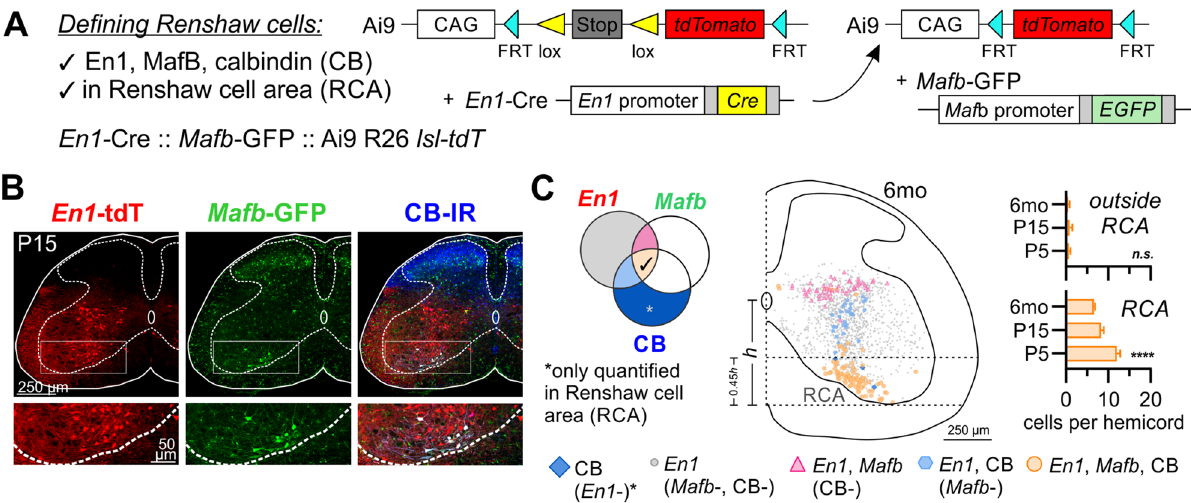
Figure 1. Genetic strategy to identify and define Renshaw cells. (A) Triple transgenic En1- Cre :: Mafb- GFP :: Ai9 R26 lsl-tdT animals label Mafb- expressing cells with GFP and the V1 lineage with tdTomato (tdT). ( B) 2D projection of a triple fluorescence confocal image stack (50 µm thick) showing En1 -tdT (V1 interneurons, red), Mafb- GFP (green), and calbindin immunoreactivity (CB-IR, blue) at P15. ( C) Venn diagram illustrates co-localization possibilities between En1 -tdT, Mafb- GFP, and CB-IR; colors match cell plots obtained from a 6-month old animal (12 superimposed 50 µm thick sections). V1-MafB cells appear as distinct dorsal and ventral groups; the ventral group is CB-IR and corresponds to Renshaw cells. The Renshaw cell area (RCA) was anatomically defined as the bottom 45% of the deep ventral horn. This region includes the vast majority of triple-labeled cells ( ● orange circles); less than one triple-labeled cell per hemicord was observed outside this region across all time points. Graphs show quantification of triple-labeled cells at P5, P15, and 6 months of age inside or outside the RCA (n = 2–4 animals per group, errors bars = S.D.; see Supplemental Table 3). Within the RCA, 98% of CB-IR cells co-express En1 -tdT and Mafb- GFP by P15. Asterisks indicate significance level after One-Way ANOVAs across all conditions. ****p < 0.0001, n.s. non-significant. For pair-wise comparisons and details of statistics, refer to Supplemental Table